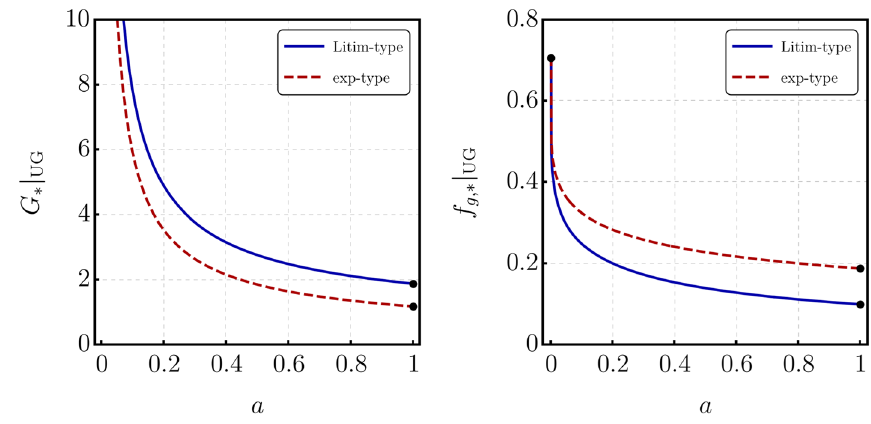
Fig. 2 Left panel: We show the fixed-point value for the Newton coupling, G ∗ , as a function of a for the exponential (red, dashed line) and Litim-type (blue, continuous line) cutoff for unimodular gravity. Right panel: (cid:11) (cid:11) (cid:11) We show f g , ∗ = f g , G = G ∗ which is the critical exponent at the asymptotically free fixed point for the gauge coupling, as a function of a for the two different shape functions. The result from both shape functions agrees for a → 0 and is